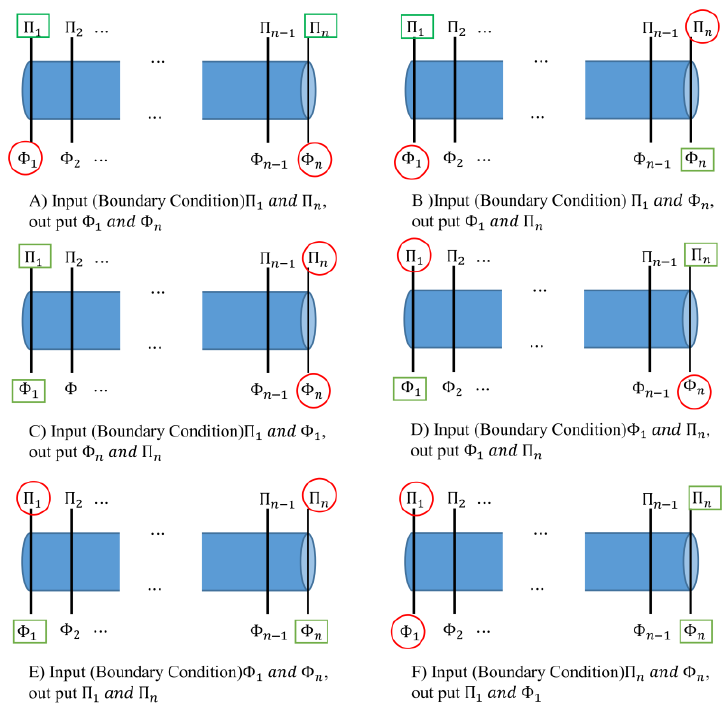
Figure. 3. Different condition for boundary conditions. Figure 3. Di ff erent condition for boundary